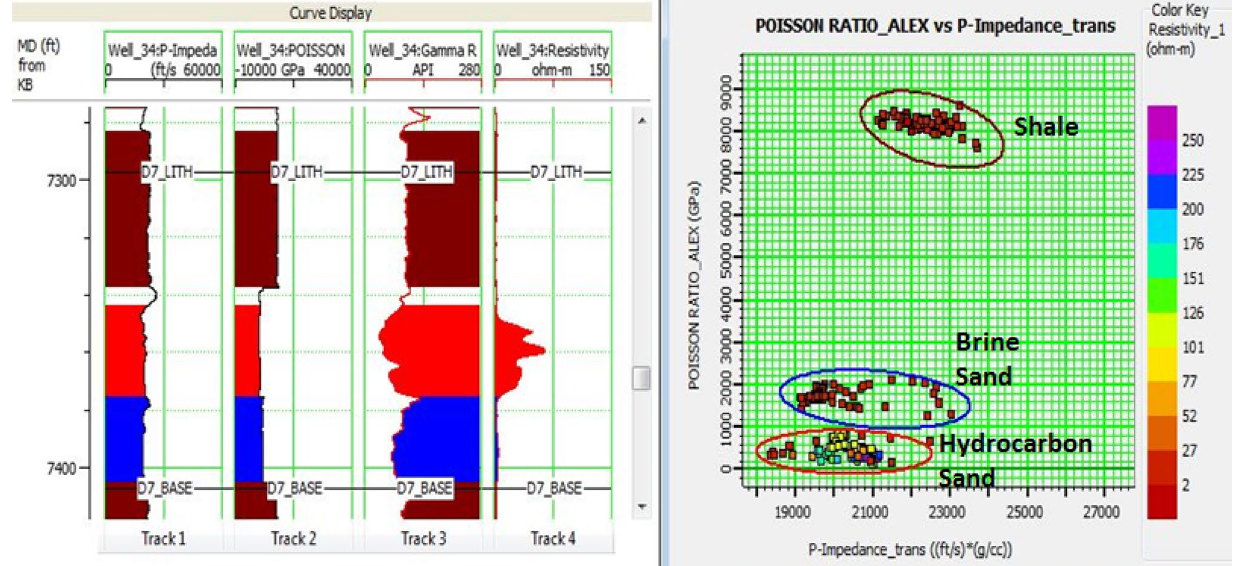
Fig. 8 Plot of Poisson ratio versus P-impedance Plot for D7 reservoir showing a good separation between sand and shale and between brine and oil